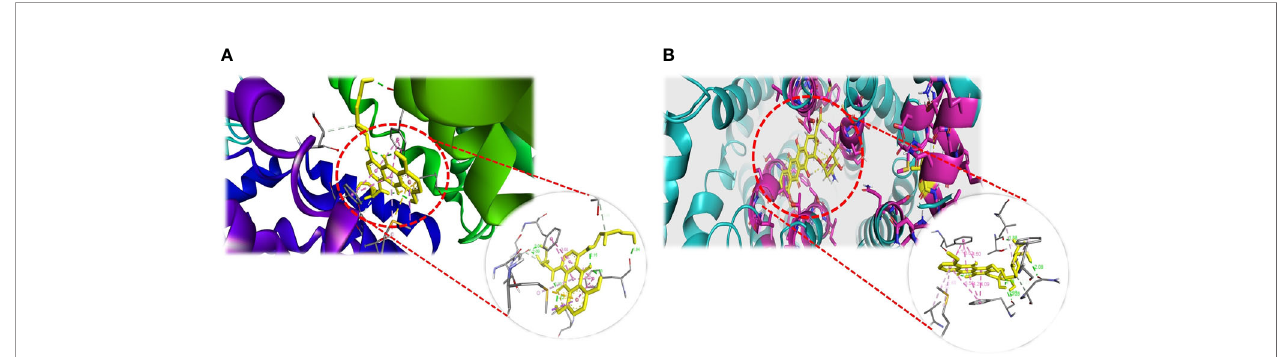
FIGURE 1 | The representation of mitoxantrone (A) and doxorubicin (B) docked with ABCG2. The ligands (mitoxantrone and doxorubicin) are shown in yellow. The active site residues are displayed as stick and the backbone of the receptor as